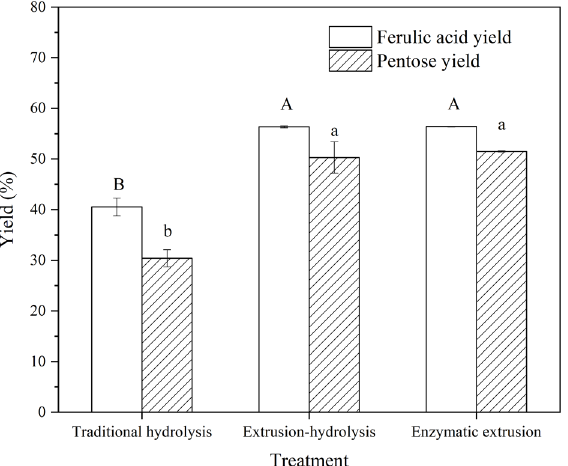
Figure 2. The yields of ferulic acid and pentose of FOs from traditional hydrolysis, extrusion-hydrolysis and enzymatic extrusion. The columns in figure with different letters are significantly different at p < 0.05, based on the Duncan’s test.